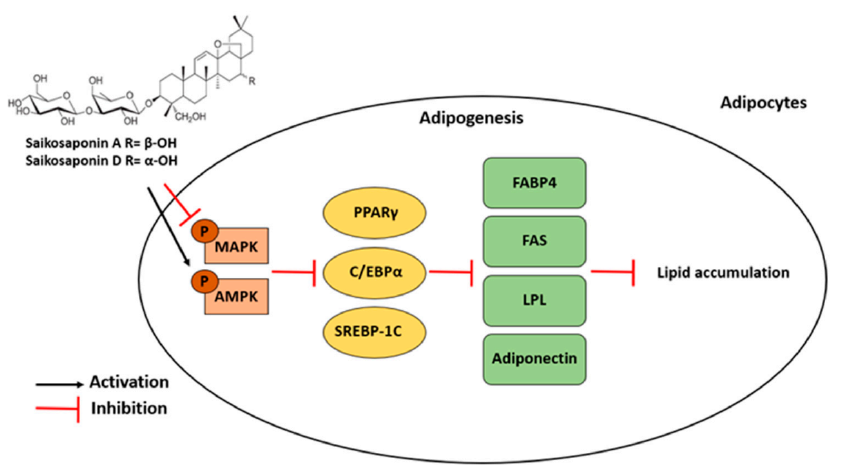
Figure 9. Suggested molecular mechanism for anti-adipogenic effect of saikosaponin A (SSA) and saikosaponin D (SSD) in 3T3-L1 adipocytes. Black arrows indicate activation and red arrows refer to